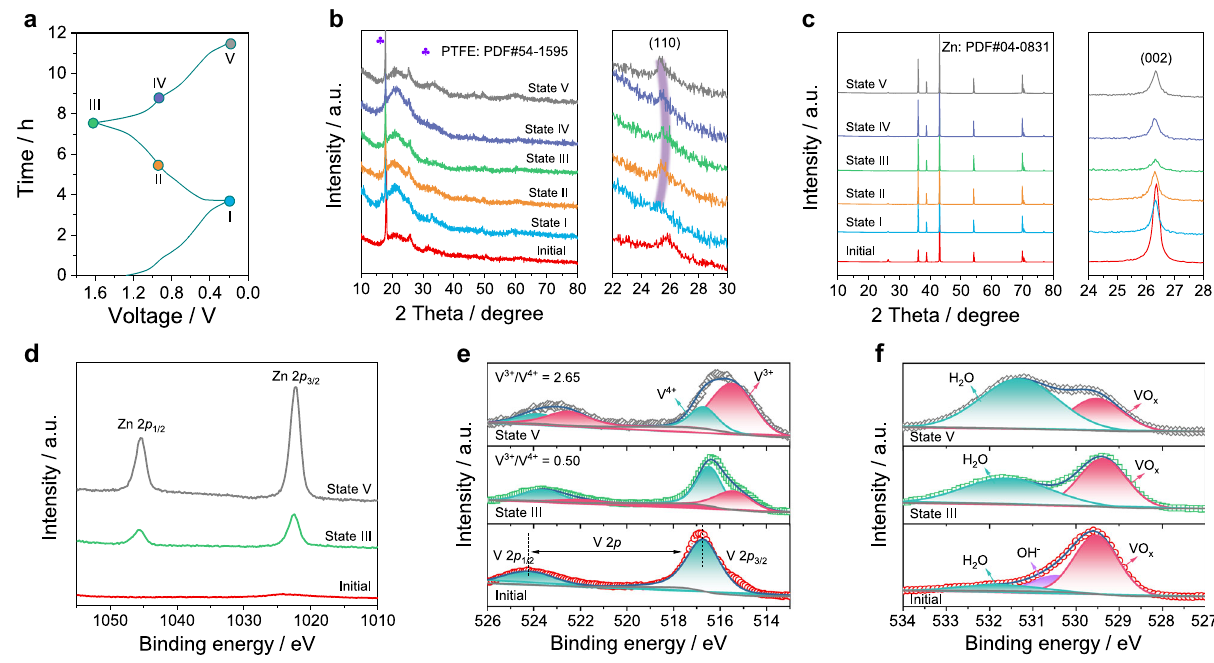
Fig. 5 The mechanism of VO 2 -PC-based ZIBs. a The GCD curves at 0.1 A g − 1 . b , c The corresponding ex-situ XRD patterns of b VO 2 -PC cathode and c Zn- G anode. d – f The corresponding ex situ XPS spectra of d Zn 2 p , e V 2 p , and f O 1 s .